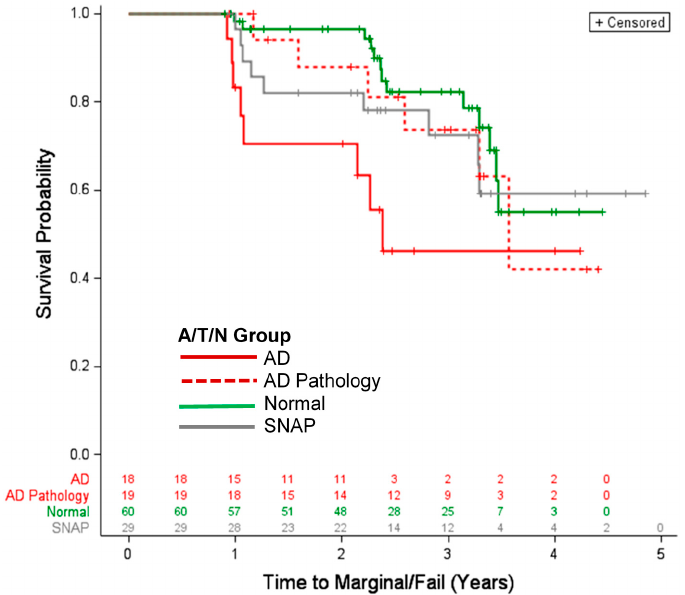
Figure 2. Time from baseline in years to receiving a Marginal or Fail rating as a function of A/T/N parent group membership, including participants with suspected non-Alzheimer’s pathophysiology (SNAP). Numbers below the X-axis indicate the number of participants at risk at that